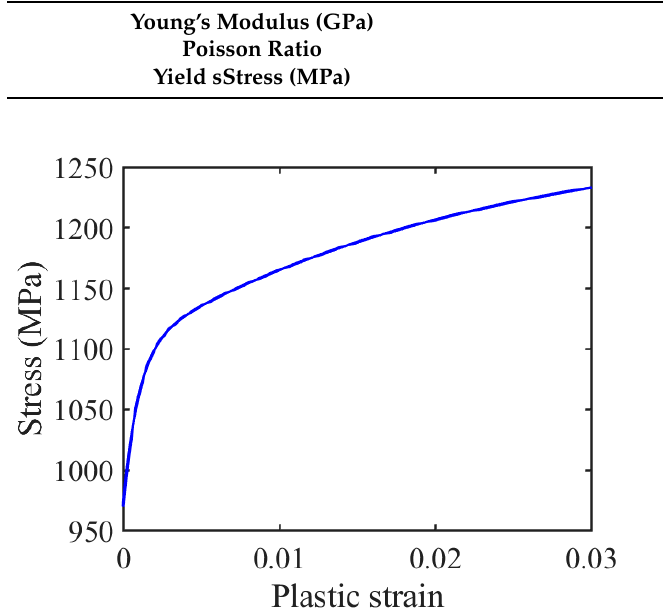
Figure 5. Relationship between plastic strain and stress.